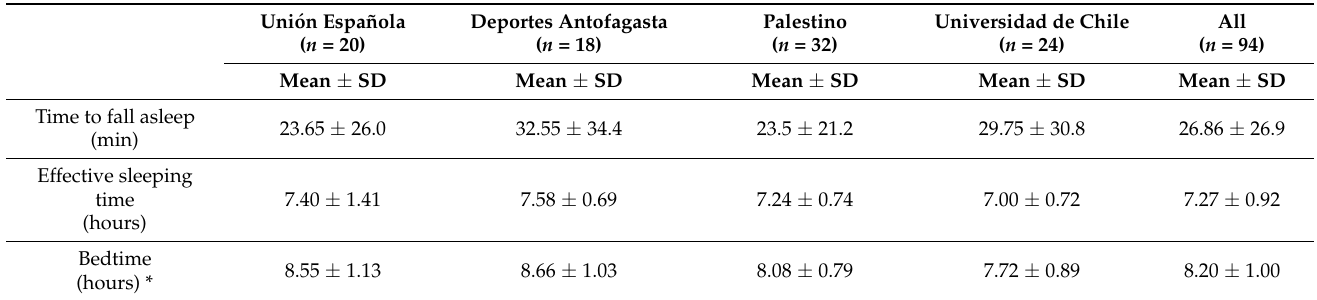
Table 1. Time and effectiveness of sleep in Chilean male professional soccer